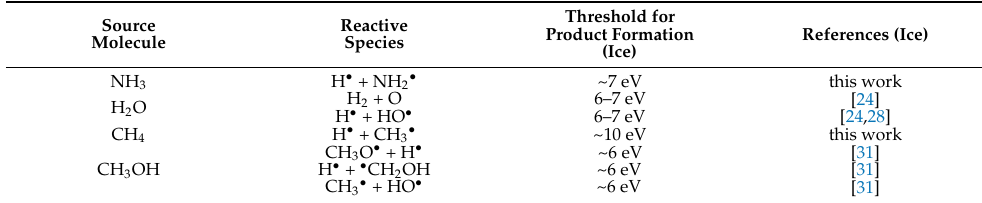
Table 3. Reactive species formed by ND as relevant to the electron-induced reactions in molecular ices discussed in Section 4. Note that the listed species were not directly detected but their contribution to the reactions is deduced indirectly from the identified final reaction products. Other electron-molecule interactions may contribute as well as summarized in Sections 3.2 and 3.4.